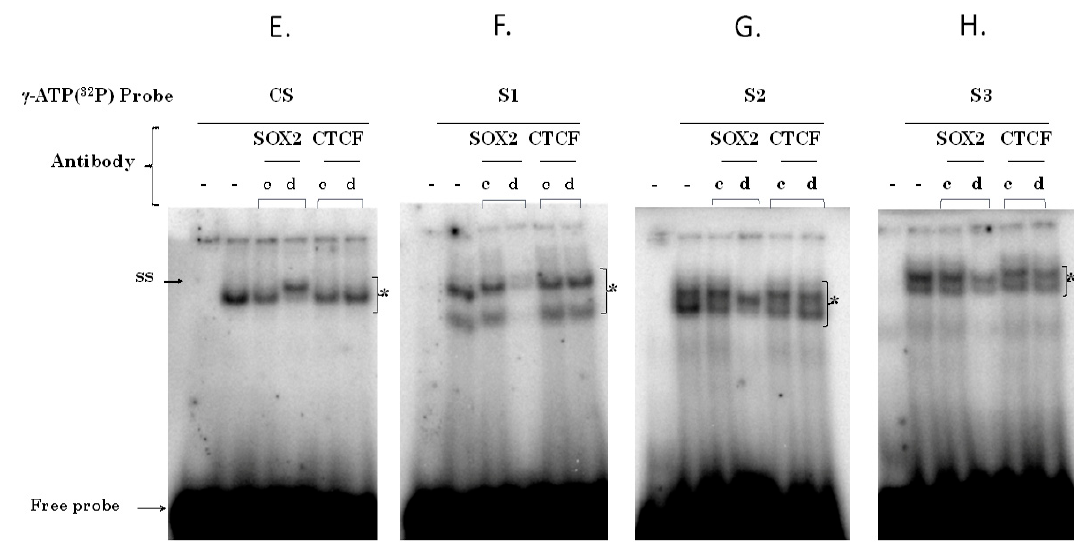
Figure 3. SOX2 binds to the putative SOX2 elements in HPV16-LCR. HeLa nuclear protein extracts were used in electrophoretic mobility shift assay (EMSA), to analyze the interactions between SOX2 and double-stranded DNA probes containing the three putative SOX2 binding sites (S1, S2 and S3) and the consensus binding site (CS). The first lanes of all the EMSAs are without nuclear extract; all the other lanes contain 15 μ g of nuclear extract. Competitions with 60 (a) or 260 (b) fold excess of S1, S2, S3, NS (non-specific) and CS cold probes are shown ( A – D ). DNA-protein complexes are denoted by (*). Free-labeled probes are shown at the bottom of the EMSAs. EMSAs E – H show the DNA-protein complexes with the respective antibodies added (anti-SOX2 or anti-CCCTC-binding factor (CTCF), as indicated) at 50 ng (c) or 2500 ng (d). SS is the supershift formed with the CS probe and 2500 ng (d) of anti-SOX2 antibody (E). In F – H , a clear decrease in the DNA-protein complexes from each probe (S1, S2 and S3) was observed with 2500 ng (d) of